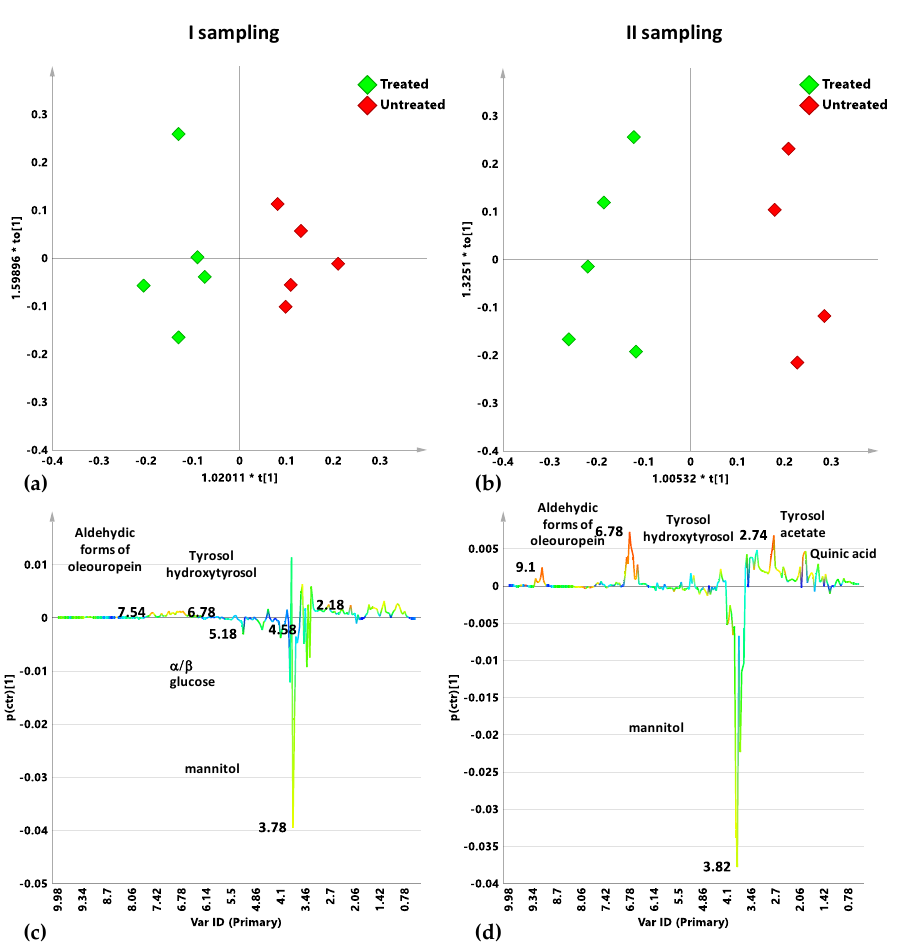
Figure 6. OPLS-DA t[1]/t[2] scores plot for infected control (red diamonds) and Dentamet ® treated (green diamonds) Leccino leaf samples from I ( a ) and II ( b ) samplings. S-line plots for the I ( c ) and II ( d ) sampling related models visualizes the p(ctr)[1] loading colored according to the absolute value of the correlation loading,